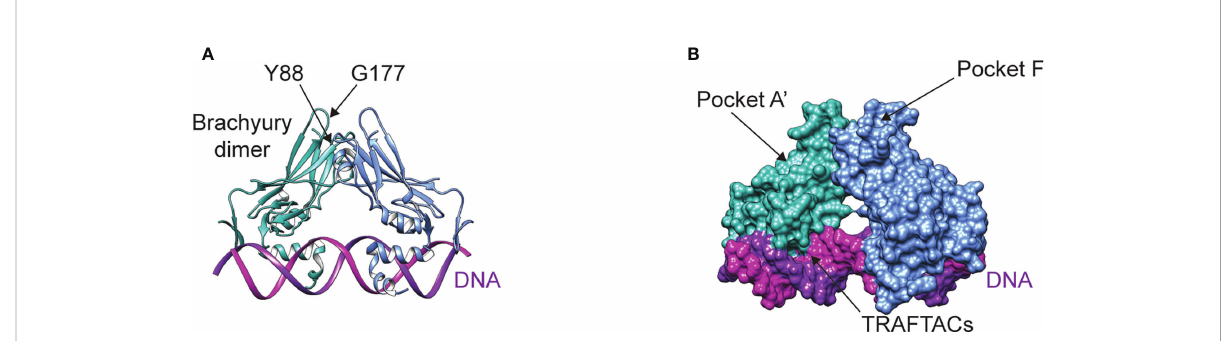
FIGURE 3 (A) Structure of the brachyury dimer bound to DNA (PDB ID 6F58). The alpha carbons of residues Y88 and G177 are separated by a distance of ~9 Å (B) Brachyury rendered in surface representation, showing the two main pockets being targeted by open-source drug discovery efforts and the DNA binding interface targeted by